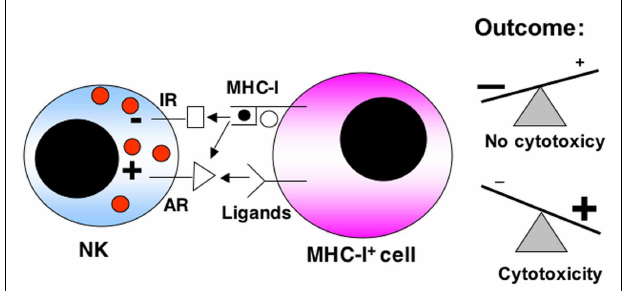
FIGURE 1 | Schematic representation of the balance between activating (AR) and inhibitory receptors (IR) in NK cell anti-tumoral function. Receptors for MHC-I can be either inhibitory or activating.The expression levels of MHC-I or of the different ligands for the activating receptors on the target cell is of paramount importance in the final response.The final outcome between both types of signaling will determine if there is a cytotoxic response or